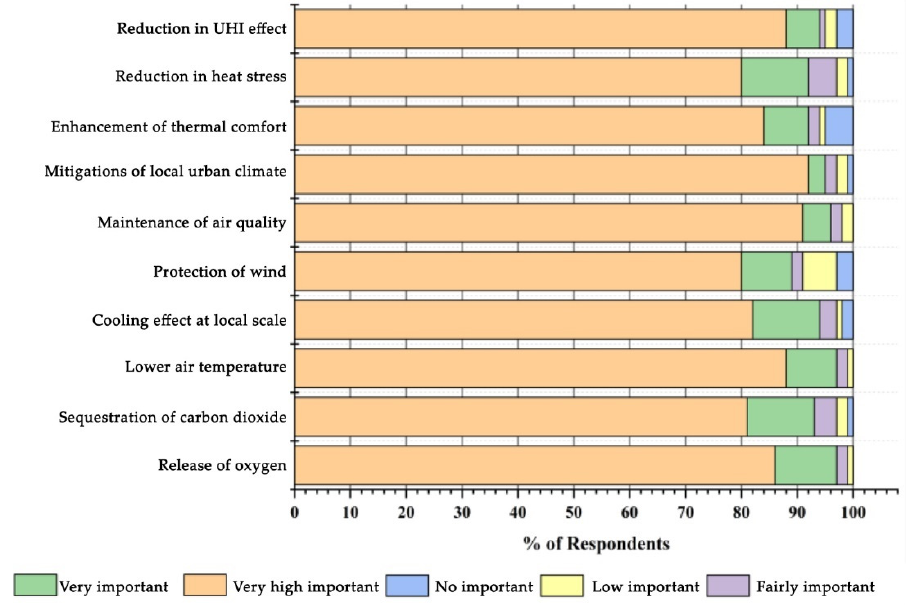
Figure 6. Role of GSs for climate regulation.